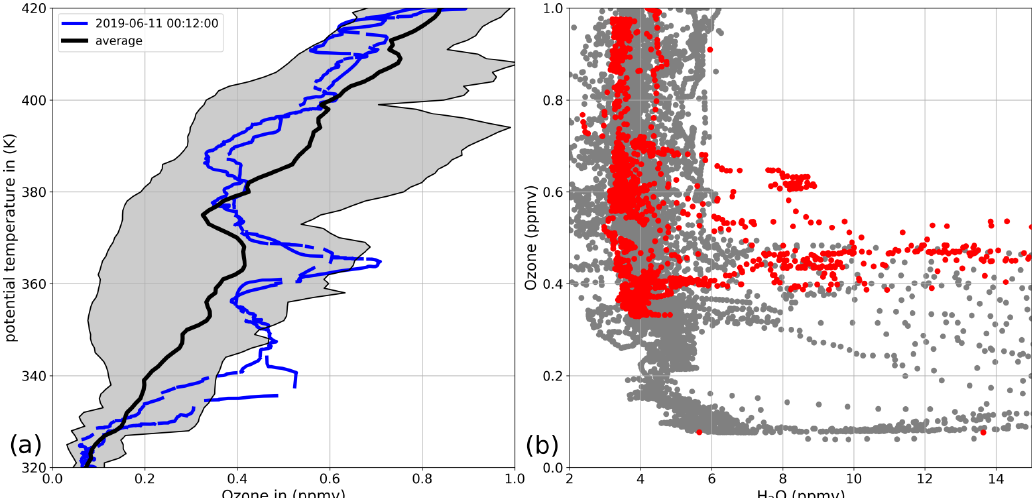
Figure 5. Climatology of eight ozone profiles measured during spring and summer 2018–2020. (a) Ozone profiles, within the UTLS altitude range from 2018 to 2020, launched in the mid-latitudes in potential temperature coordinates. The shaded area marks the measured range of the ozone mixing ratios. The blue line shows ascent and descent data from the from case 1. (b) Tracer–tracer correlation of water vapor and ozone mixing ratios within the UTLS altitude range for the data obtained from 2018 to 2020 in the mid-latitudes. The red dots show the data from the ascent and descent from case 1.